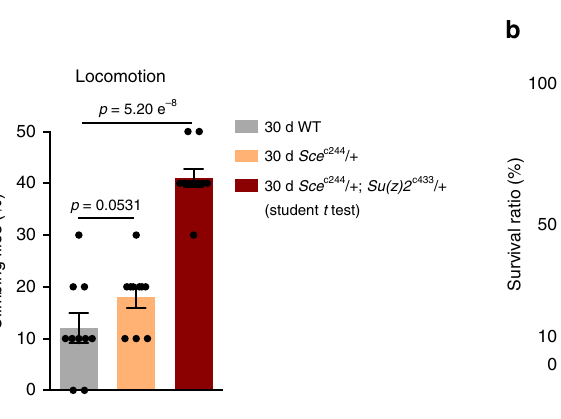
Sample preparation for LC-MS analysis . Head, muscle and testis tissues were homogenized in ice-cold urea lysis buffer containing 8M urea, 100mM Tris-HCl, pH 8.5, 150 mm NaCl, and protease inhibitor (Pierce, USA). The homogenate was centrifuged using 14,000 × g for 10min, and the protein concentration of the preparation 53 .